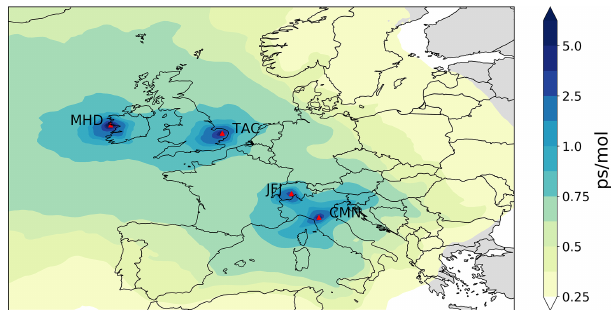
Figure 1. Average footprint emission sensitivity in picoseconds per mole (psmol − 1 ) obtained from NAME 30d backward calculations for the four measurement sites – Mace Head (MHD), Tacolneston (TAC), Jungfraujoch (JFJ) and Mt. Cimone (CMN) – during 2015. Measurement sites are marked as red triangles.